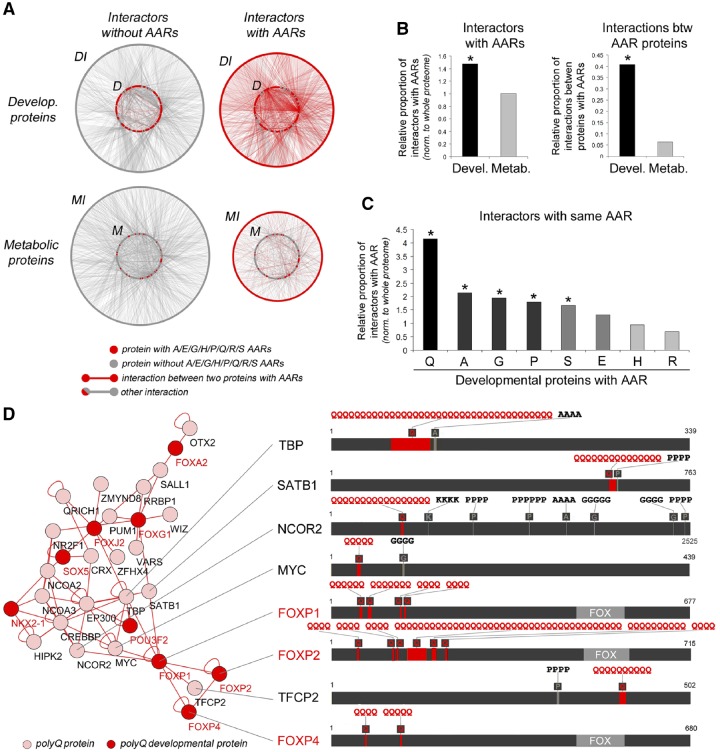
—Overrepresentation of PPI-mediating AARs in the interactome of DPs. (A) Compact graph representation of the interactomes of 167 DPs and 167 control MPs randomly chosen among those involved in carbohydrate and lipid metabolism, in which individual proteins are represented as adjacent dots forming circles. Each protein dot is colored in red, if the protein contains an AAR, or in gray if not. DPs (D) form the inner circle in the upper graphs, MPs (M) form the inner circles in the lower graphs. Their interactors (DI and MI, respectively) are represented in the external circles. Gray edges connecting pairs of proteins represent PPIs, which are in red if connecting two proteins with AARs. (B) The left histogram shows the relative proportion of interactors of proteins bearing the indicated AARs that contain that same AAR (e.g., proportion of polyQ proteins among the interactors of polyQ-containing DPs). Values are normalized to the proportion of proteins containing the same AAR in the whole proteome. The right histogram shows the relative proportion of interactions between proteins that contain AARs. Asterisks mark significant overrepresentations. (C) Histogram representing the relative proportion of A/E/G/H/P/Q/R/S AAR-containing proteins in the interactomes of DPs and MPs shown in A. Values are normalized to the proportion of proteins containing the same AARs in the whole proteome. Asterisks mark significant overrepresentations. (D) Graph representation (left panel) of an interactome formed by polyQ-containing DPs and their polyQ interactors. The right panel highlights a subnetwork of FOXP1 interactors, representing their AARs as in Figure 1A.